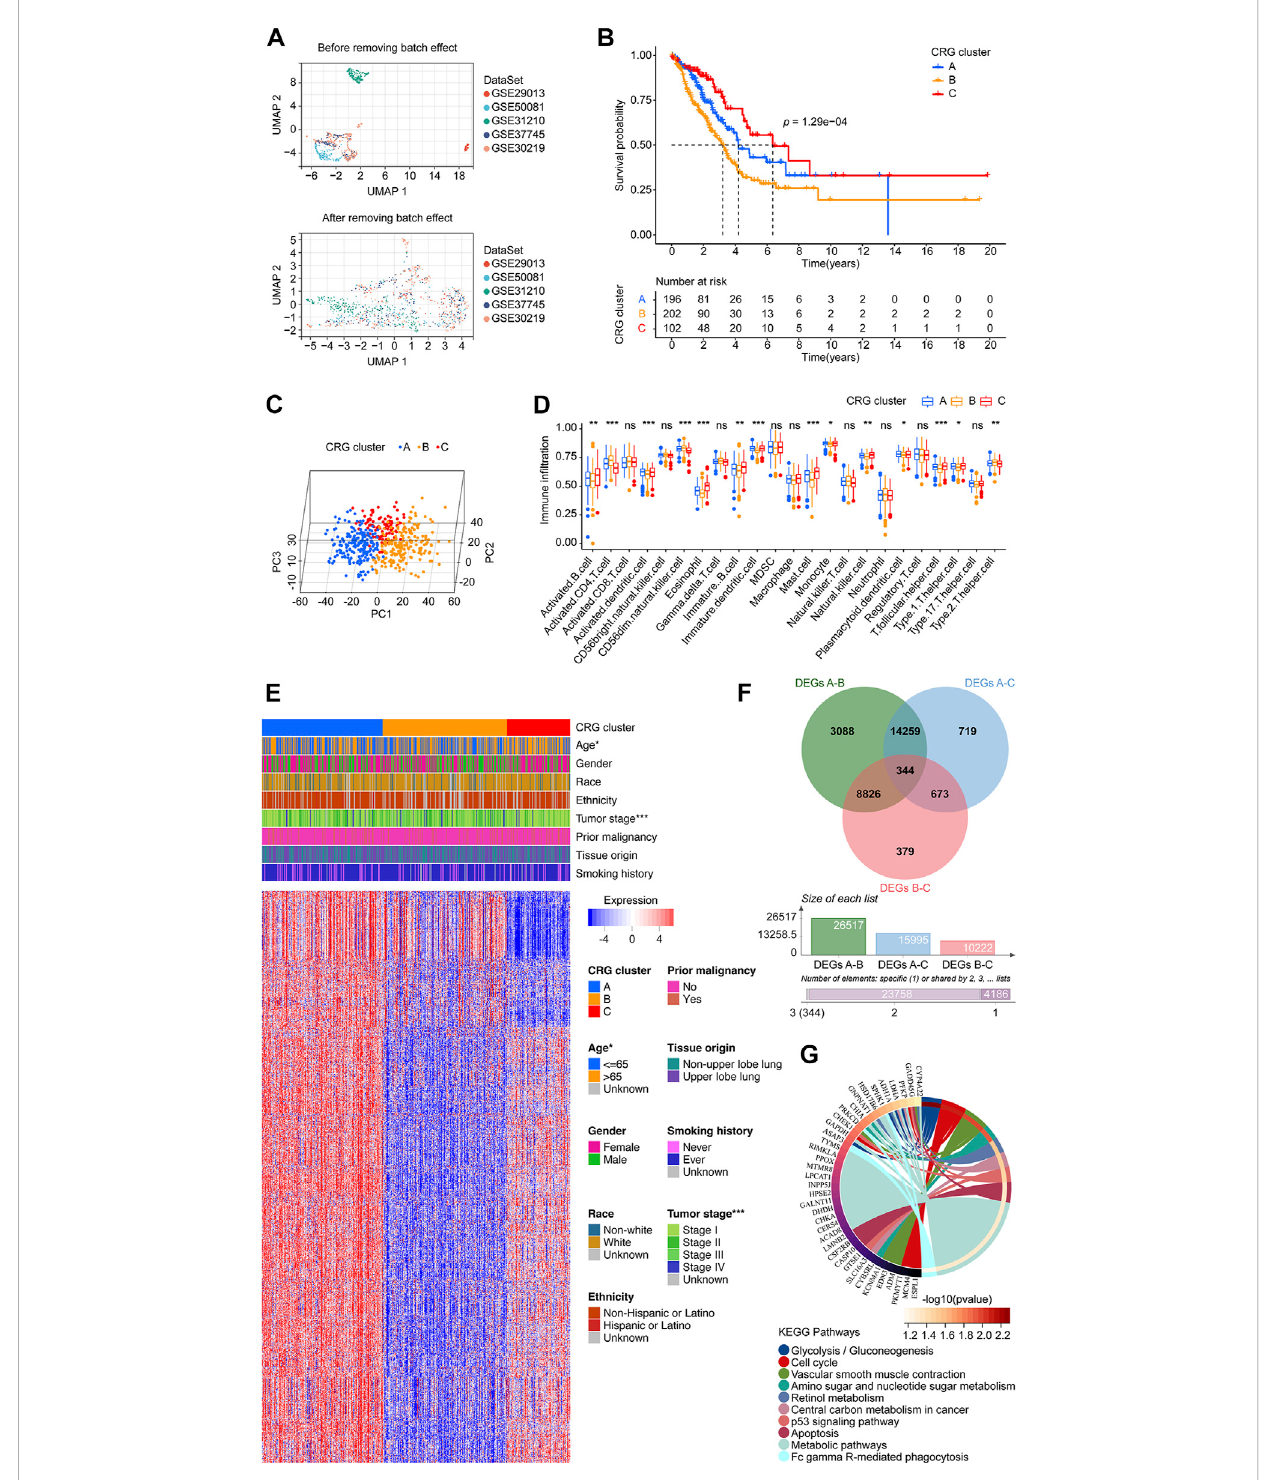
FIGURE 2 Data preprocessing and the CRG clusters construction. (A) UMAP plot shows validation cohort merged before batch effect removing, displaying that the samples of each dataset are separated from each other. UMAP plot shows validation cohort merged after batch effect removing, displaying that samples of each dataset are clustered and intertwined with each other. (B) The KM survival curve demonstrated that the overall survival of patients in the CRG clusters were signi fi cantly different. The cluster C had a more favor prognosis better than that of patients in cluster B and C, while the cluster B population had a promising outcome than that in the cluster C. (C) Principal component analysis scatter plot shows three clusters were obviously separated. (D) In fi ltration distribution of immune cells in the three CRG clusters. (E) Heatmap shows the relationship between CRG clusters, clinical parameters, and 1175 CRG co-expressed genes. Each row represents a gene, and each column represents a sample. (F) Venn diagram shows the process of obtaining the 344 CRG-DEGs. (G) KEGG analysis shows the top 10 enriched